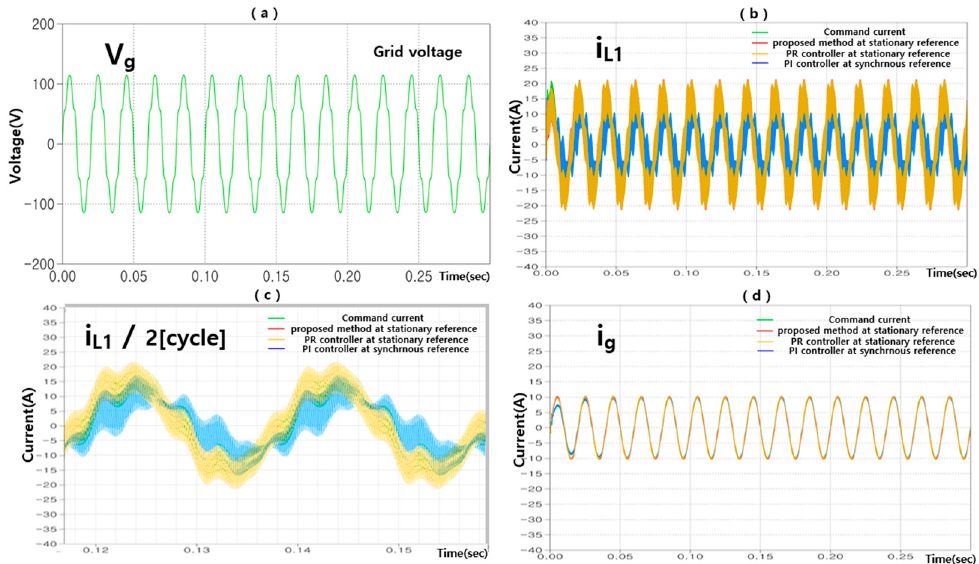
Figure 6. Simulation results of measured actual grid voltage and estimated grid voltage through the single-phase grid current observer, ( a ) actual and estimated grid voltage ( b ) error between actual and grid voltage.